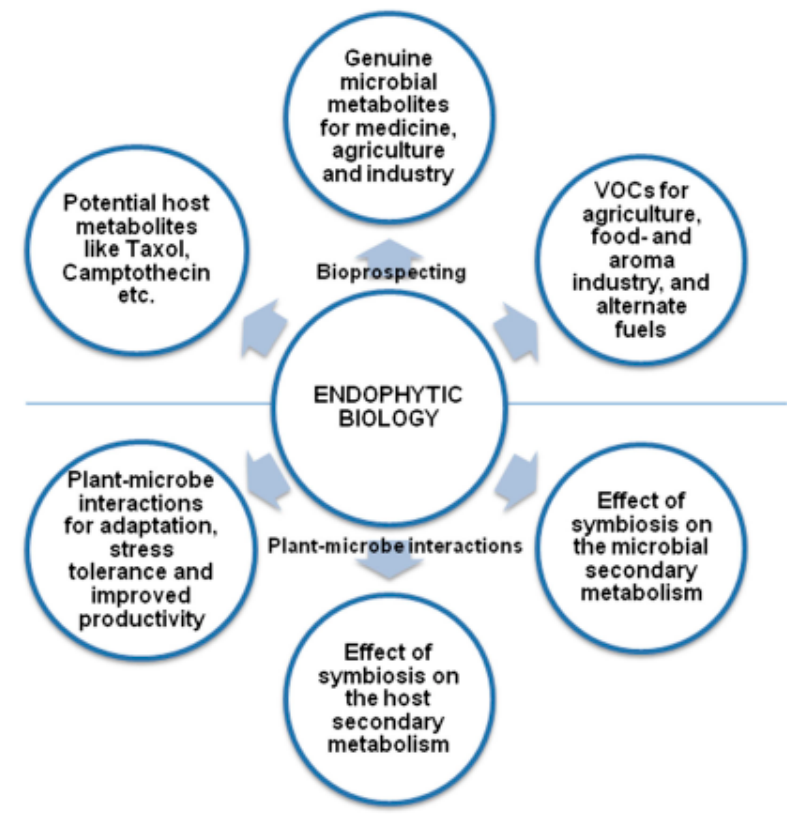
Figure 1. The biological study of endophytes.